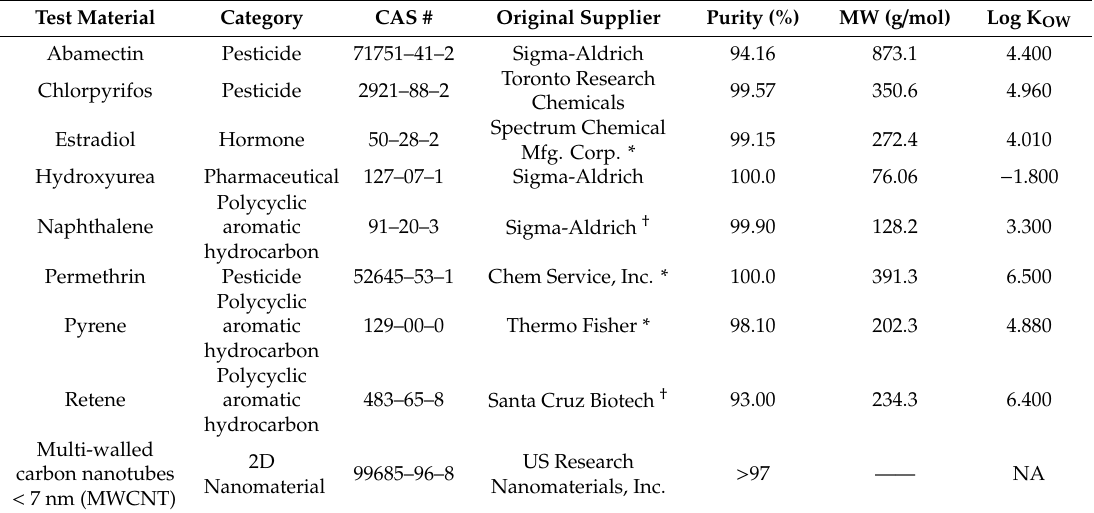
Table 1. Test agent